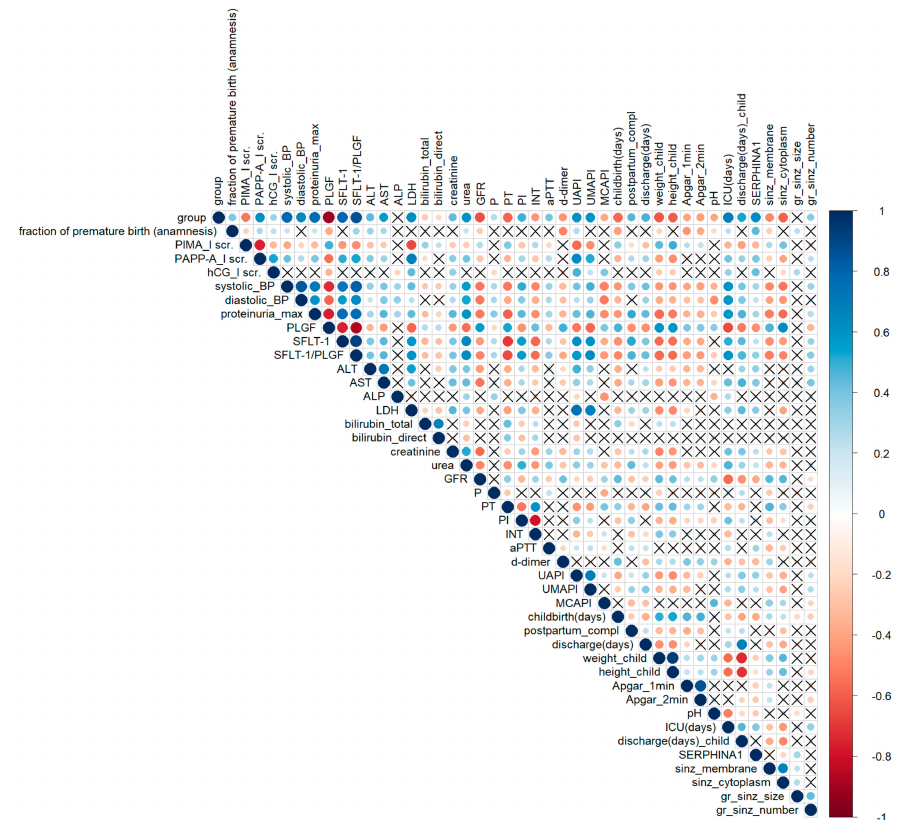
Figure 2. Spearman’s correlation analysis of clinical data, the expression level of SERPINA1 in the urine and placenta at a confidence level of 0.05. A positive correlation is highlighted in blue, and a negative correlation is highlighted in red. The degree of correlation is highlighted in color—the stronger the correlation, the darker the color. “X”—statistically insignificant data. The parameter groups correspond to an increase in the severity of the pathology: 0—control, 1—chronic arterial hypertension (CAH), 2—PE-CAH, 3—mild PE, 4—severe PE. Premature—fraction of